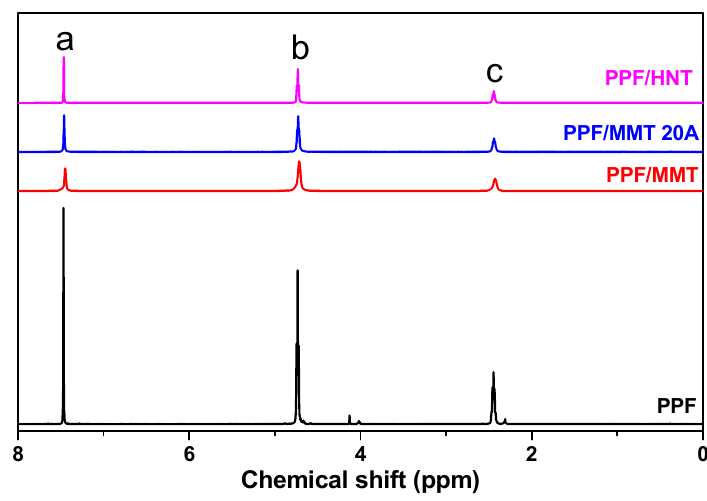
Figure 1. 1 H-NMR spectra of PPF and its nanocomposites with MMT, MMT 20A, and HNT.